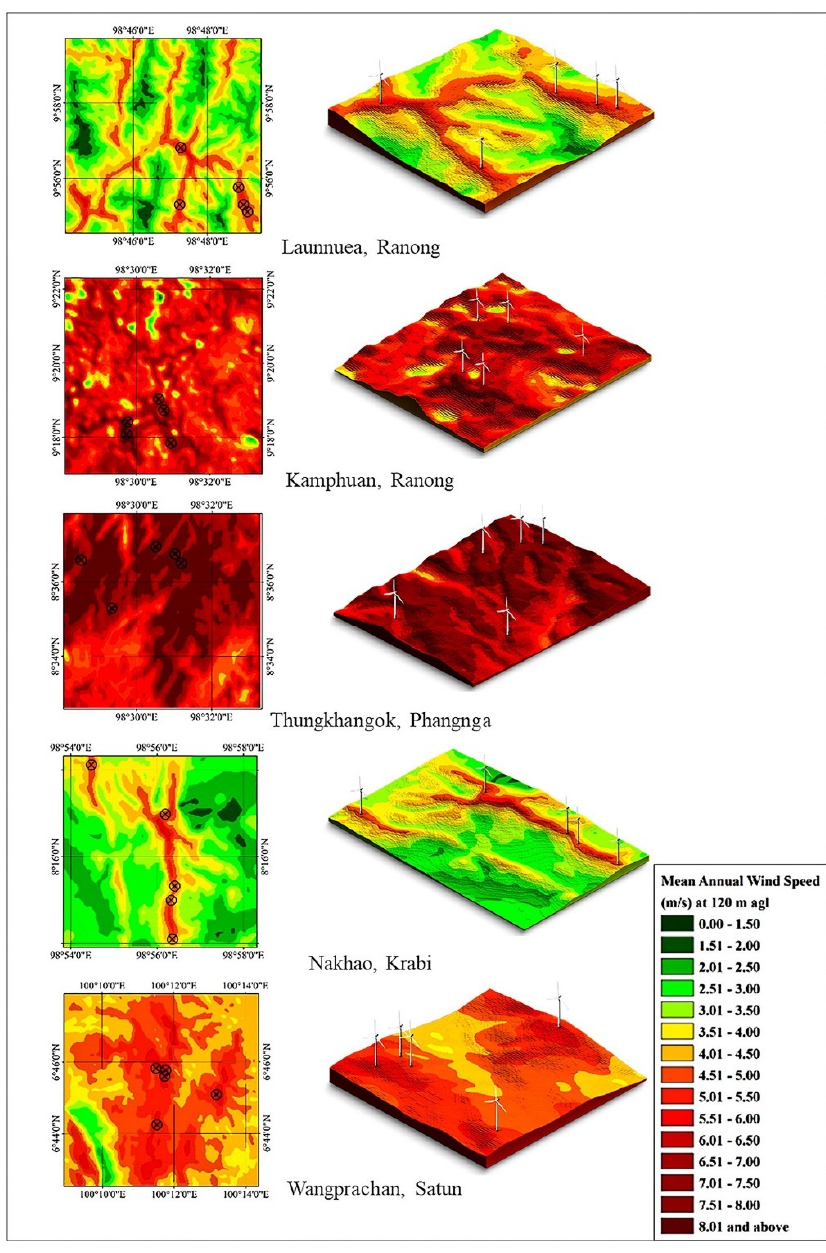
Figure 11. The 2D and 3D optimized WTG layouts of the wind power plants in the potential sites of development.